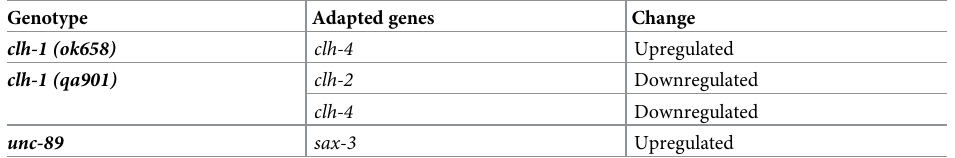
Table 1. Mutant clh-1 and unc-89 that cause transcriptional adaptation and their adapting genes.